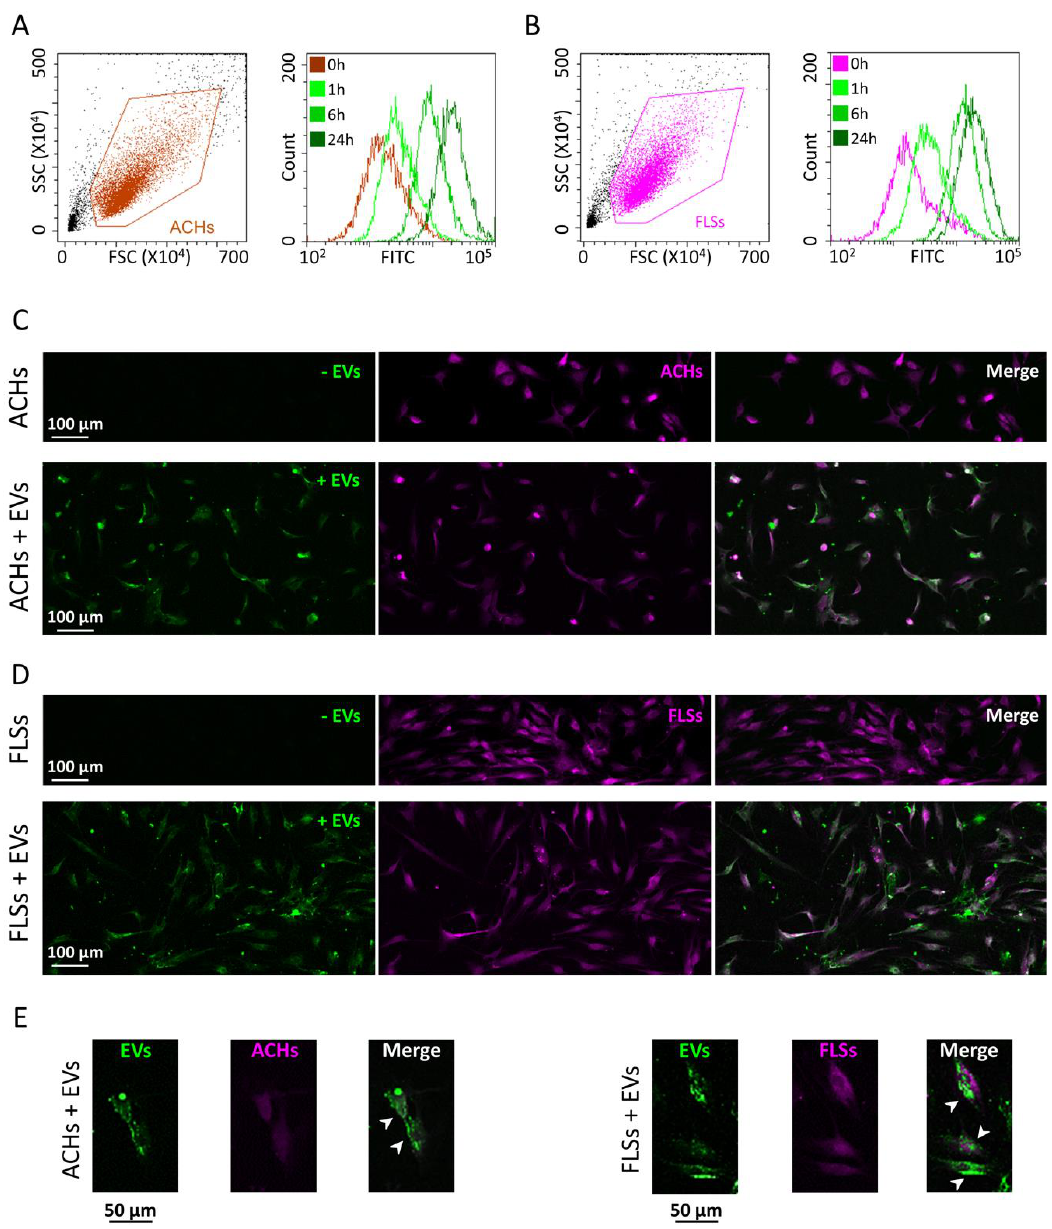
Figure 3. ASC-EV interaction with ACHs and FLSs over time in 2D. ( A , B ) Cytograms at time 0, 1-6-24 h for ACHs and FLSs incubated with ASC-EVs showing an increase in FITC-channel intensity signal over time. One representative donor is shown. ( C , D ) Images at time 0 and after 24 h of ACHs and FLSs grown in 2D and incubated with ASC-EVs. EVs were CFSE-stained and are shown in green, whereas cells were stained with CellTracker ™ Deep Red Dye and are shown in violet. One representative donor is shown. ( E ) Magnification of ACHs and FLSs interaction with ASC-EVs that clearly stain in a punctuate fashion the cytoplasm and perinuclear area of single cells, as indicated in the merge pictures by the white arrows.